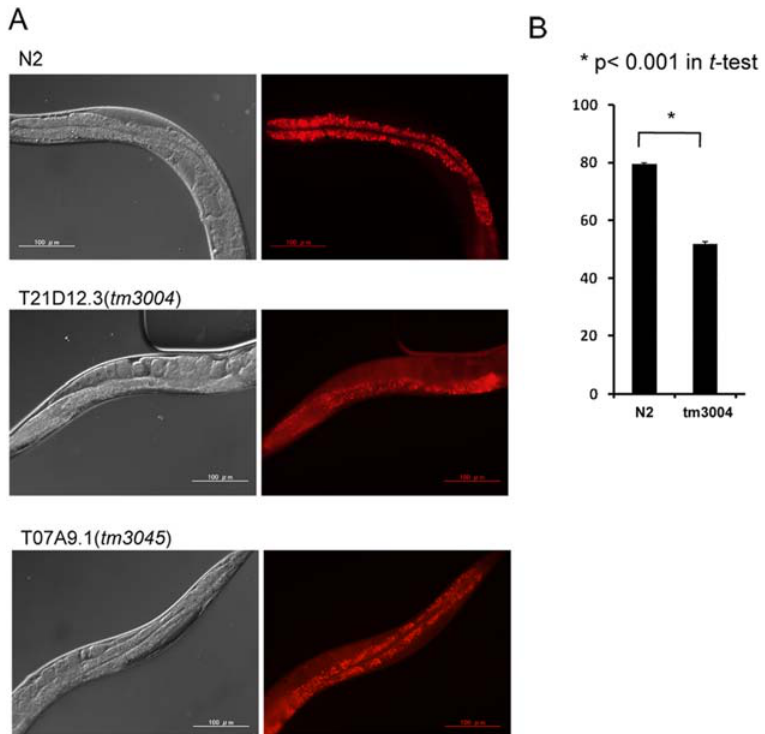
Figure 6. Morphological analysis of lipid storage in intestinal cells. A) Worms were stained by culturing from the L1 stage to adult stage on a Nile Red-containing plate. Control worms (N2) show strong stains in intestinal cells. In the T21D12.3 mutants, Nile Red stains intestinal cells weakly and the stain signals in body cavity outside of eggs seem higher than that of N2. Nile Red stains in the T07A9.1 mutants were not changed so remarkable. B) Nile Red staining signals in intestinal cells were analyzed quantitatively by collecting signals from 6 worms (25 m m 2 ). Asterisks indicate p , 0.001 in Student’s t-test. Quantitative analysis showed a significant difference between N2 and T21D12.3 mutants but not between N2 and T07A9.1